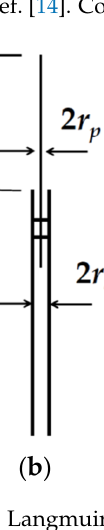
( b ) Figure 2. ( a ) Probe scheme. ( b ) Relevant dimensions of a Langmuir cylindrical electrostatic probe design. Both the size of the probe and the size of its container were carefully chosen so that the required conditions for a good design of the probe were met [22,51,52]. In order for